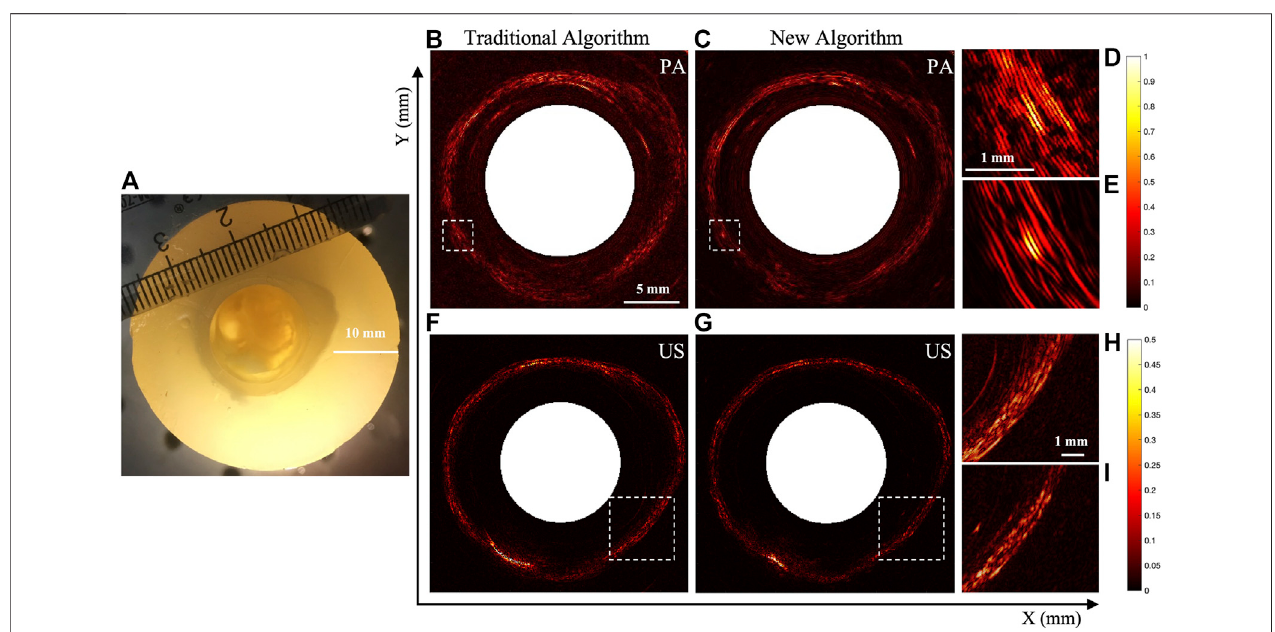
FIGURE 6 | Image reconstruction results of photoacoustic/ultrasonic endoscopy of porcine small intestine. (A) Photograph of Phantom 2. (B-E) Photoacoustic imaging results (F-I) Ultrasonic imaging results. (B,F) are obtained with the traditional algorithm, and (C,G) are obtained with the new algorithm. (D,E) and (H,I) are the magni fi ed images of the white boxes in (B,C) and (F,G) ,